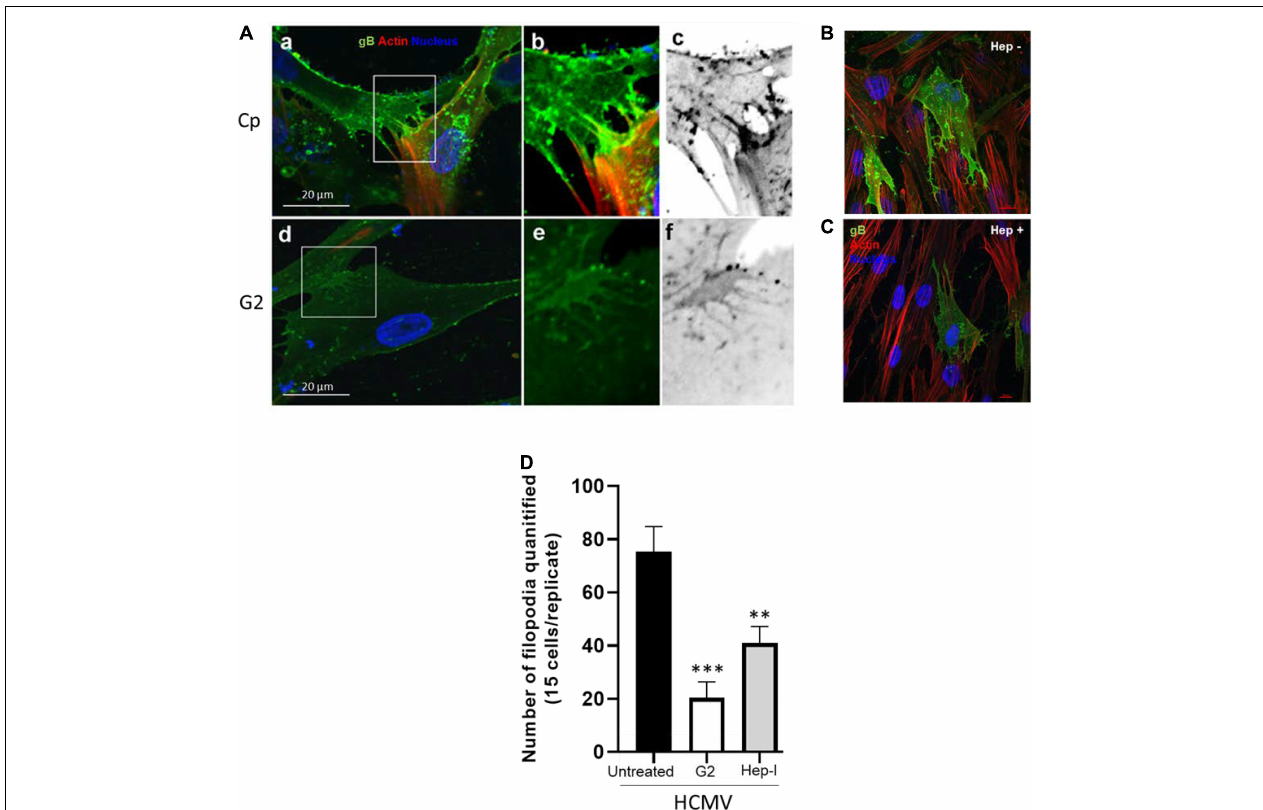
FIGURE 4 | Pre-treatment of HIS cells either with the anti-3- O S HS (G2) peptide and/or with heparinase-I interferes with the induction of filopodia and HCMV infectivity. (A) HIS cells pre-treated with control peptide (Cp) (a–c) and/or pre-treated with anti-3- O S HS (G2) peptide (d,e) for 2 h followed by HCMV infection at 10 MOI for 60 min. The cells were washed and fixed for imaging HCMV infection and filopodia induction. The cells pre-treated with Cp had a large number of viruses on the filopodial bridges between cells (a–c). In contrast, cells treated with G2 peptide had significantly a smaller number of filopodia and fewer viruses on HIS cells (d,e). (B) In this experiment, HIS cells were pre-treated with heparinase-I at 1.0 U/ml (C) and/or mock-treated (PBS) for 1 h followed by HCMV (10 MOI) infection for 2 h. The cells were then washed and fixed with FITC conjugated anti-gB antibody and phalloidin staining to detect virus and the filopodial growth using Nikon A1R confocal imaging at × 40. (D) The quantification of cellular filopodia for each group (mock treated; G2 peptide, and heparinase-I treated) is based on 15 cells randomly picked per triplicate experiment. Asterisks indicate significant difference from controls and/or treatments ( p < 0.005, one-way ANOVA followed by post hoc Bonferroni test) and error bars represent